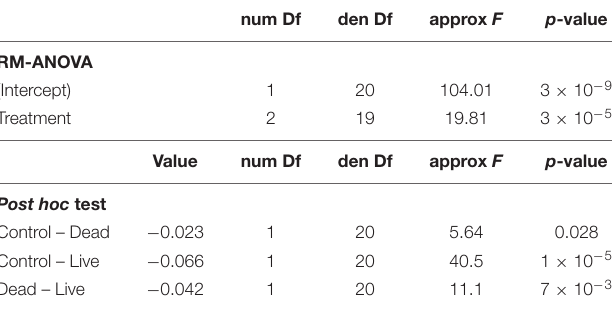
TABLE 1 | Results of the RM-ANOVA applied to assess differences in Microphytobenthos (MPB) biomass between the three treatments in the inner bed